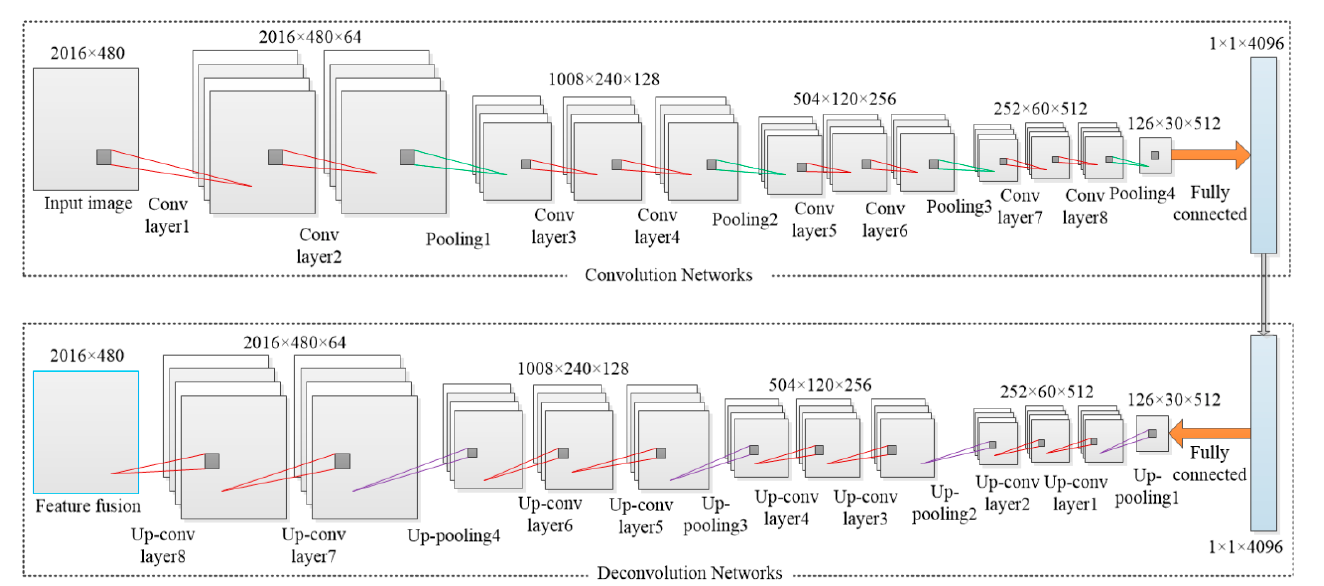
Figure 2. Structure diagram of the B-SCAN image feature curve extraction network.